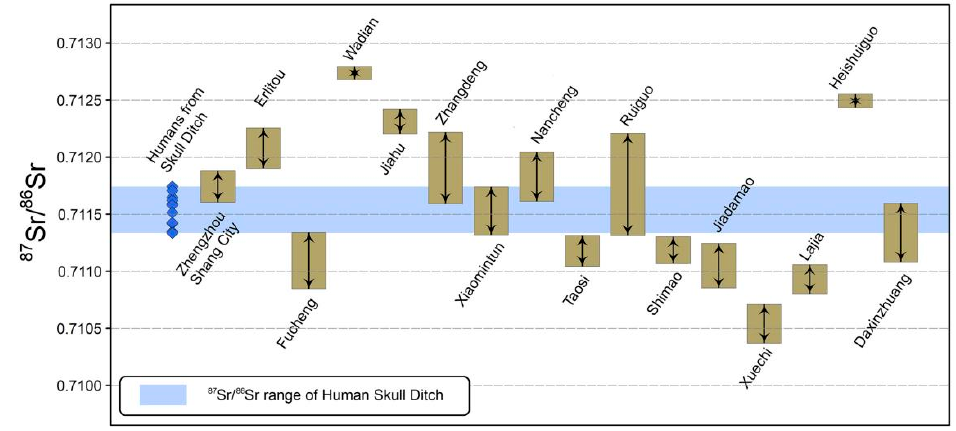
Figure 5. 87 Sr/ 86 Sr values from the human skull ditch and the other 16 sites.